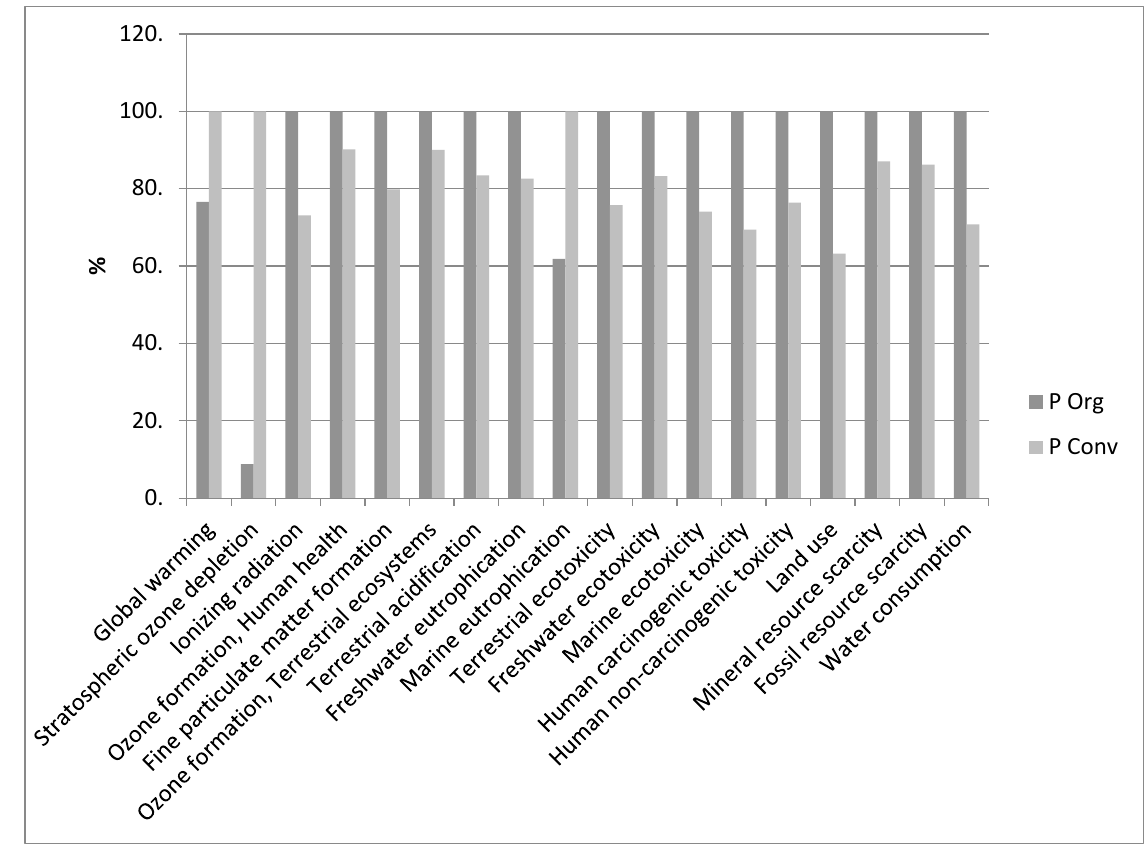
Figure 3. Impact comparison per kg of organic and conventional production of the early potato (% of average value for each category).